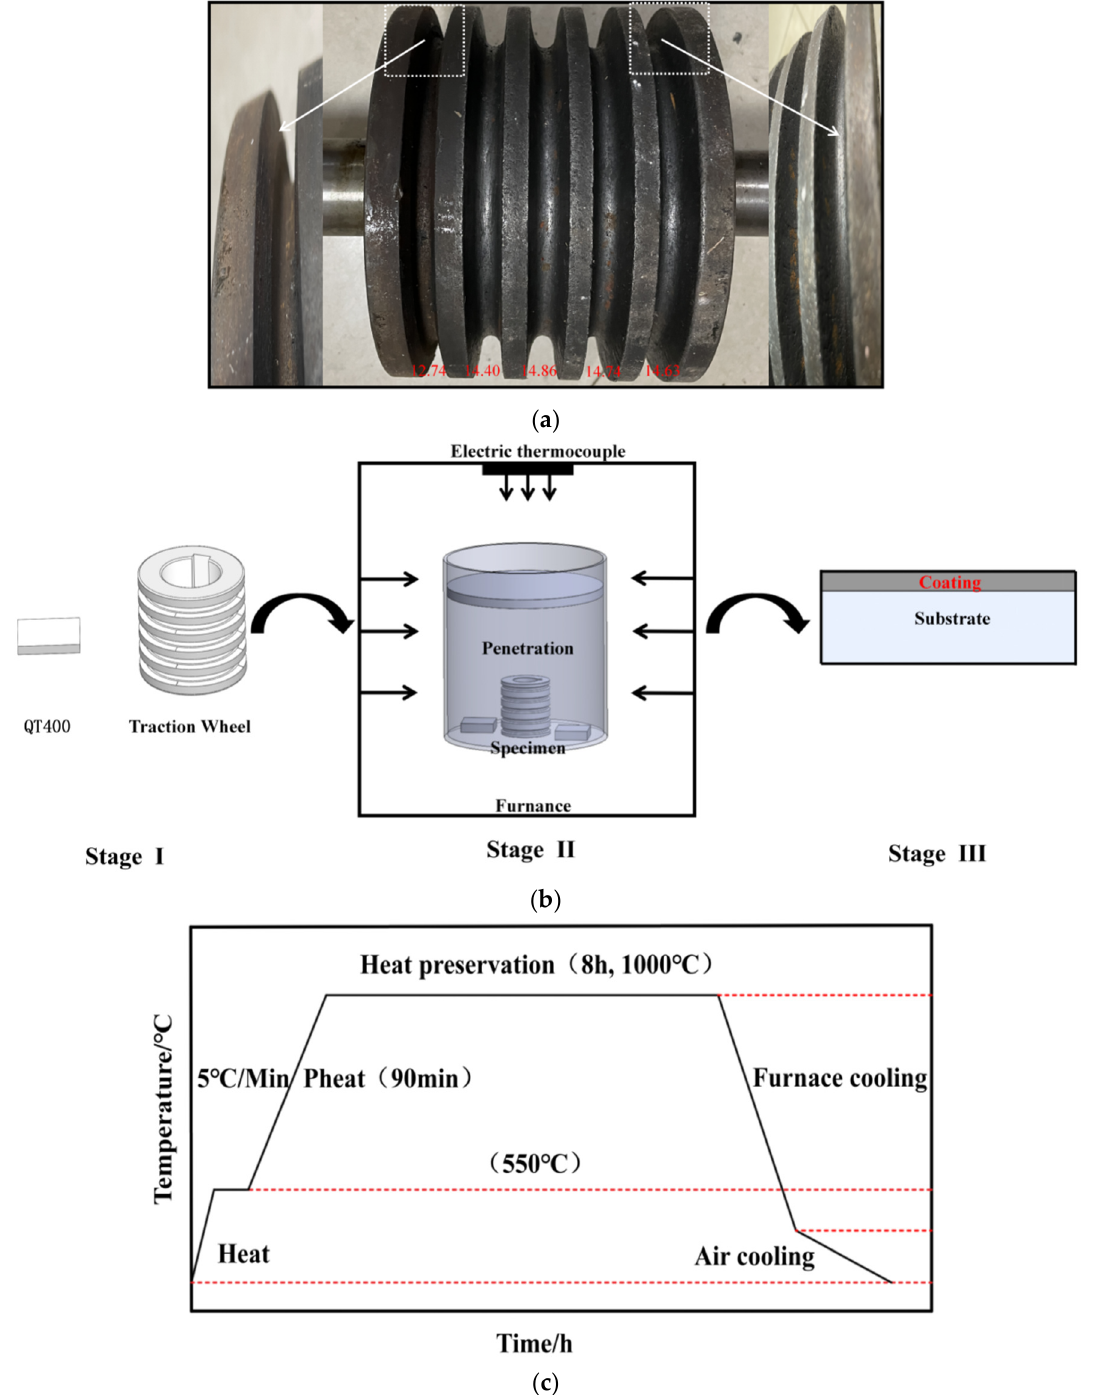
Figure 1. Failed traction wheel and thermal-diffusion chromizing process. ( a ) Failed traction wheel. ( b ) Schematic diagram of the chromizing process. ( c ) Processing technology.